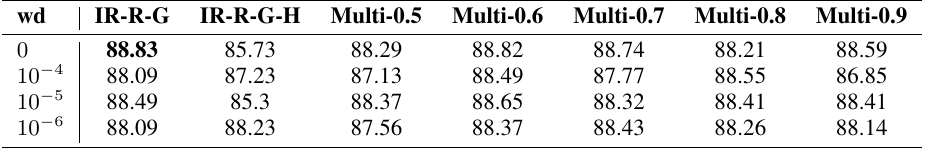
Table 1. Overall test accuracy for semantic segmentation with different settings. 0.x in Multi-0.x denotes the weight applied to the semantic segmentation loss. For regression, the corresponding weight is (1 - 0.x). Changing the weights of the individual losses in the multi-task models also has no clear effect on the result. Moreover, com- paring the multi-task results to those from the baseline setting, no regularization on the semantic segmentation task is observ- able. The same observation has been made in (Srivastava et al., 2017).